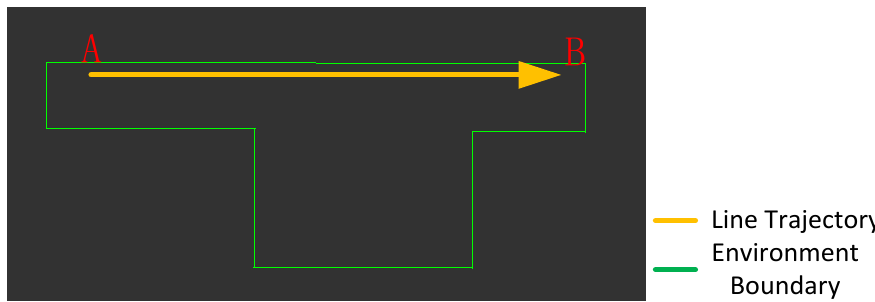
Figure 7. The simulated indoor environment and presetting of the UGV